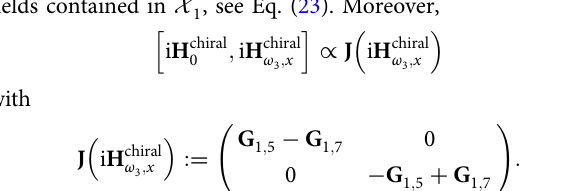
Fig. 2 Rotational subsystem for enantiomer selective excitation. The subsystem consists of the states J ¼ 1 ; τ ¼ (cid:2) 1 ; M j i , J ¼ 2 ; τ ¼ (cid:2) 1 ; M j i and J ¼ 2 ; τ ¼ 0 ; M j i , where J , τ , and M are the quantum numbers of the asymmetric top. The orange, (pink, and turquoise) lines indicate the transitions which are induced by fi elds with polarization σ + ( σ − , z ) and frequencies ω 1 ( ω 2 , ω 3 ), respectively. The transition in transparent magenta is not part of any of the three-wave mixing cycles. The small numbers indicate the states of the